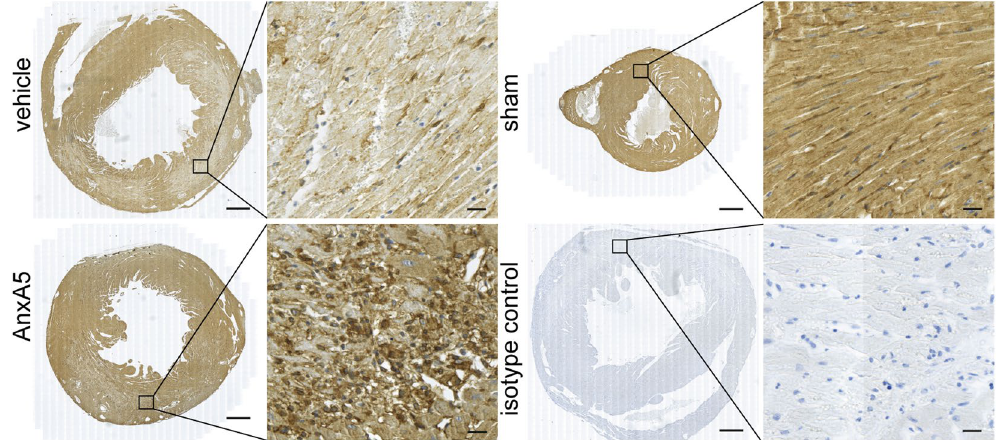
Figure 1. Annexin A5 staining. Representative images of cross-sections from the whole heart (left) or the infarct area (right) two days after MI-R stained for human annexin A5 using a specific AnxA5 antibody, while counterstaining was performed using haematoxilin. AnxA5 treated mice showed a more intense staining compared to vehicle and sham mice. Left panel scale bar: 500 μ m, right panel scale bar: 20 μ